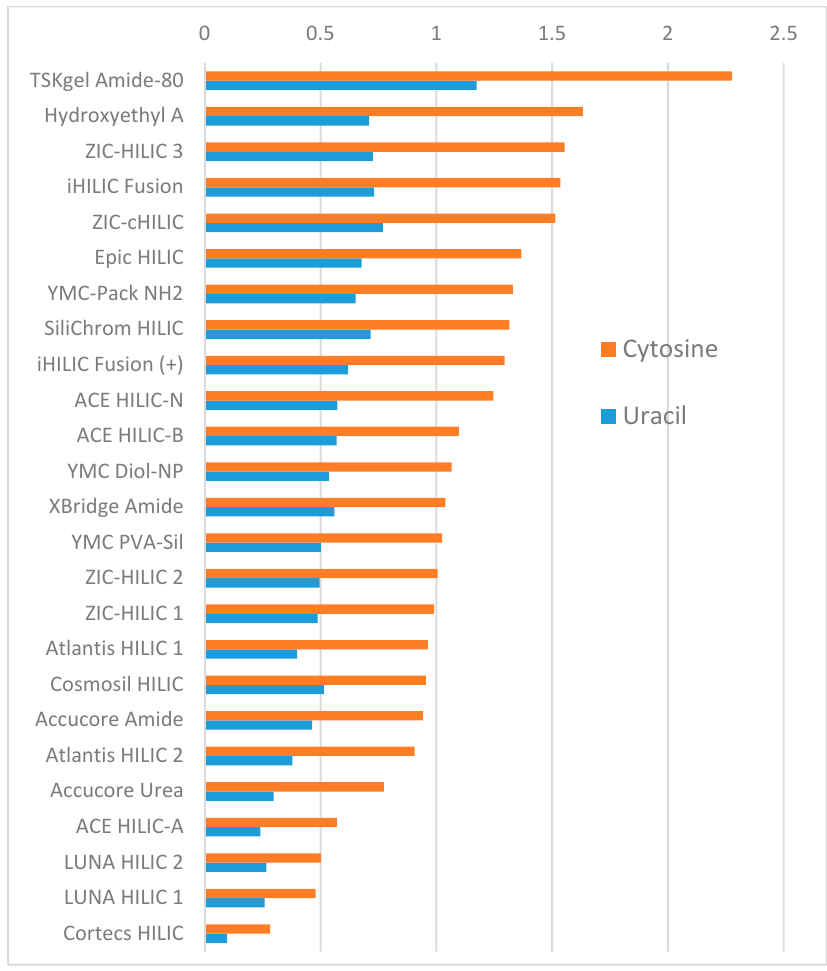
Figure 1. The retention factors of cytosine and uracil on 25 polar stationary phases in the mobile phase containing 75% acetonitrile and 5 mM ammonium acetate.